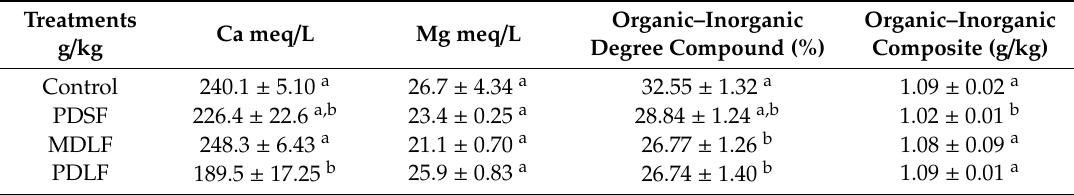
Table 1. Influence of fulvic acids (FA) on exchangeable calcium, magnesium, organic–inorganic degree compound and organic–inorganic composite after maize harvested (mean ± standard error; n = 4). Treatments